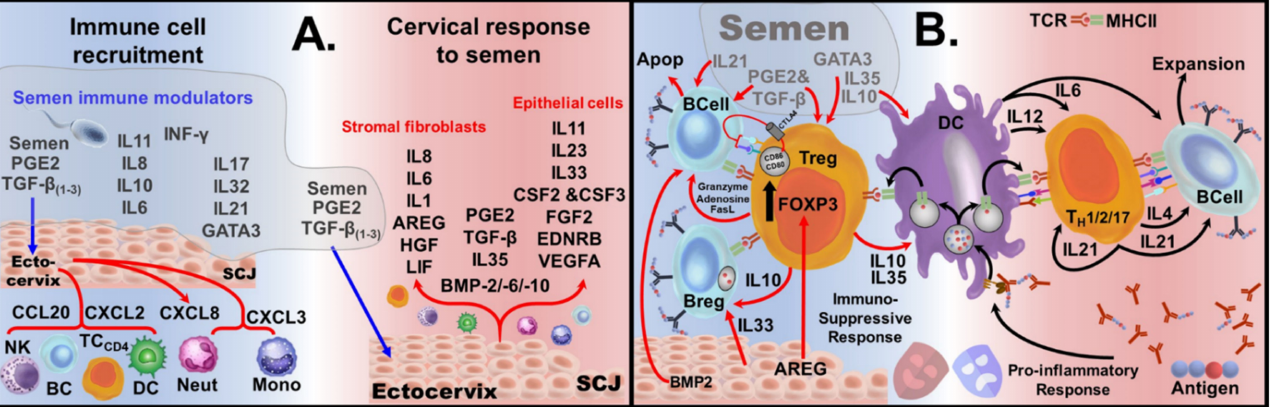
Figure A1. Cervical Response to Semen: ( A ) Major cytokines present in semen with the chemokine response of the cells of the ectocervix toward seminal PGE2/TGF β cause the recruitment of immune cells ( left ). PGE2/TGF β in semen cause ectocervix endothelial and fibroblast cells to release immunomodulators and growth factors ( right ). A combination of both male-derived and female-derived immunomodulators and growth factors are required for an optimal immune response by women toward the male-specific antigens present in semen. ( B ) ( Left ) Cytokines/growth factors generated by the interaction of semen with ectocervical cells drives the formation of Tregs, which are presented with recognized antigens. Instead of epitope presentation-induced activation of CD4 + T cells and B cells, a seminized cervix has an array of cytokines/growth factors which generate epitope-specific Tregs. In addition, B cells which are activated by antigens bound to their BCRs can be driven to apoptosis, hence lineage deletion by death signals from Treg/cytokine/growth factors (IL21, PGE2, TNF β , BMP2, granzyme, FasL and Adenosine). An alternative fate for antigen-activated B cells is class switching into Bregs, which can be induced by the presence of IL33 (cervical) and IL10. SCJ = squamous columnar junction; NK = Natural Killer Cells, TC = T cells, BC = B cells, DC = Dendritic Cells, Neut = Neutrophils, Mono = Monocytes AREG = Amphiregulin; Apop =